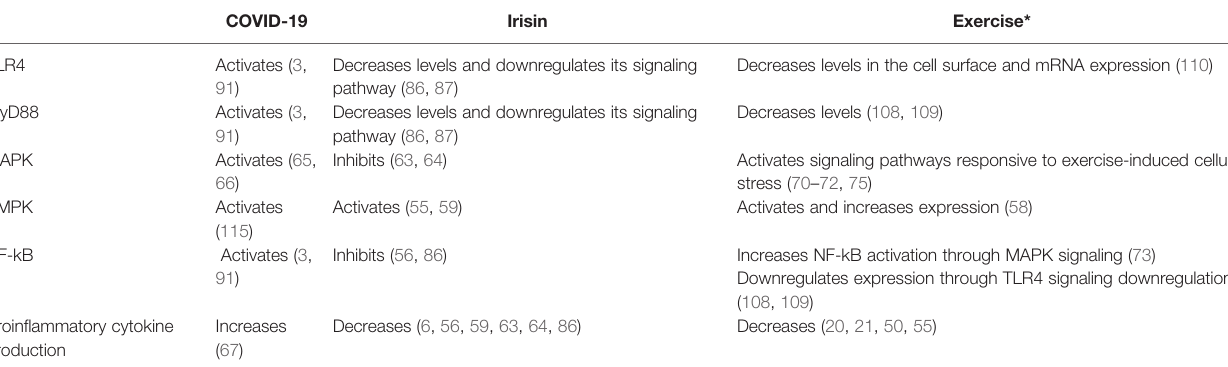
TABLE 1 | COVID-19, Irisin, Exercise, Sedentarism/Aging, and Obesity in fl uence related in fl ammatory pathways: TLR4, MyD88, MAPK, AMPK, NF-kB, and cytokine production. COVID-19 Irisin Exercise*